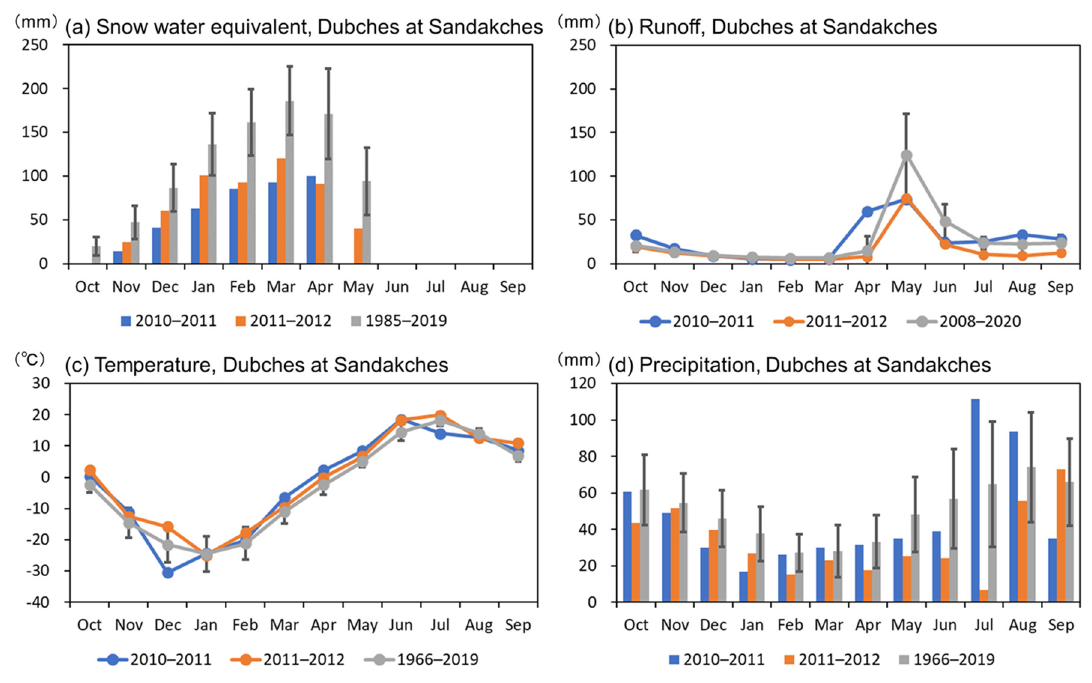
Figure 7. Seasonal change in hydrometeorological elements at Dubches at Sandakches in middle WS from October to September. The bars indicate the standard deviation of the long-term mean for the respective gray legends. The data for 2010–2011 and 2011–2012 are also depicted. ( a ) Snow water equivalent, ( b ) runoff, ( c ) temperature, and ( d ) precipitation.